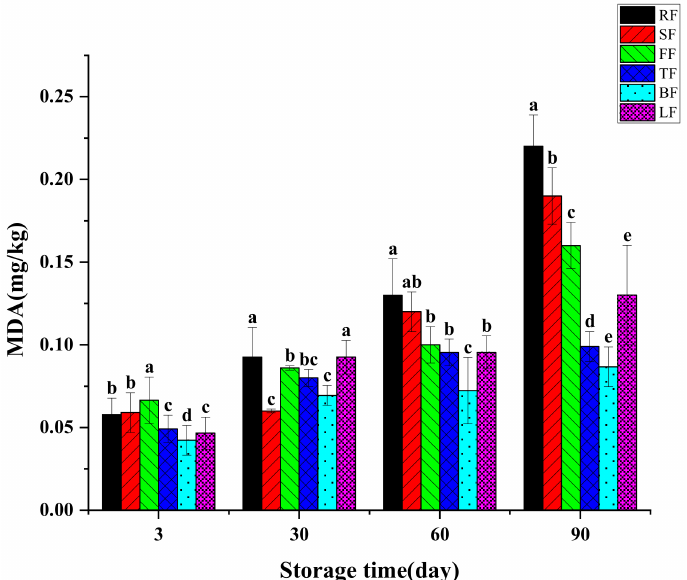
Figure 10. Change in MDA content of cuttlefish during storage at − 18 ◦ C by different freezing meth- ods. The letters “a–e” indicate significant differences ( p < 0.05). Error bars show standard